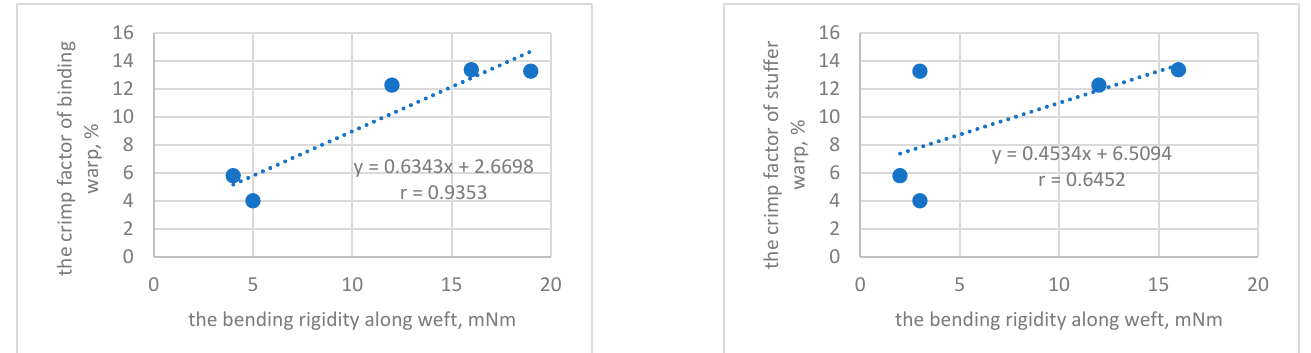
Figure 8. The relationship between bending rigidity along weft and the crimp factor of warps.